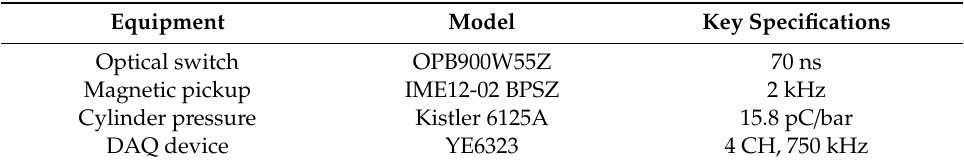
Table 2. Equipment on the test rig.